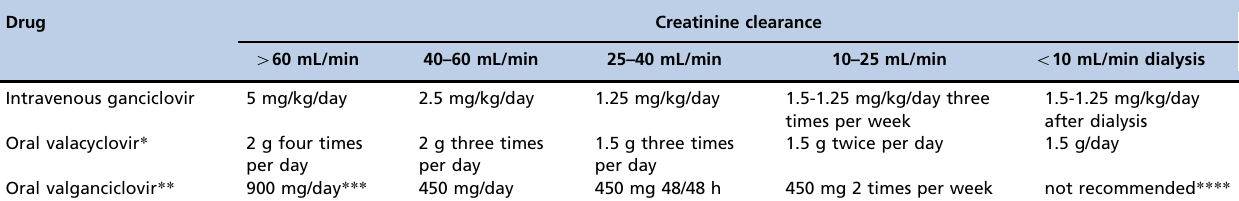
Table 2 - Antiviral drug doses recommended for prophylaxis according to the glomerular filtration rate, which is estimated based on creatinine clearance